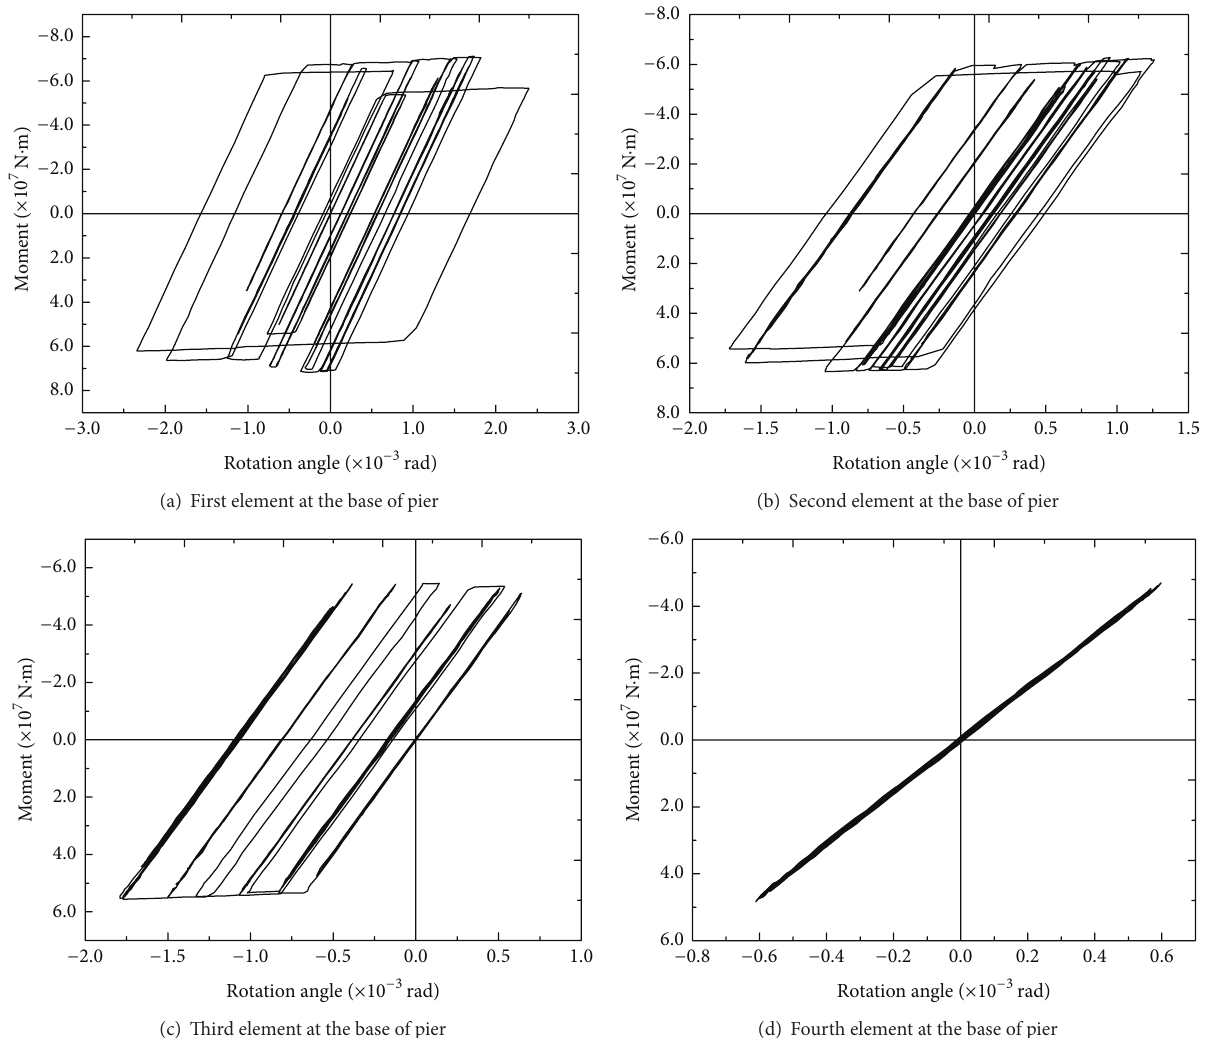
Figure 9: Moment-rotation relationship at the element of pier bottom for near-fault ground motion record of Tabas-TR with 350 km/h vehicle speed and 14 m